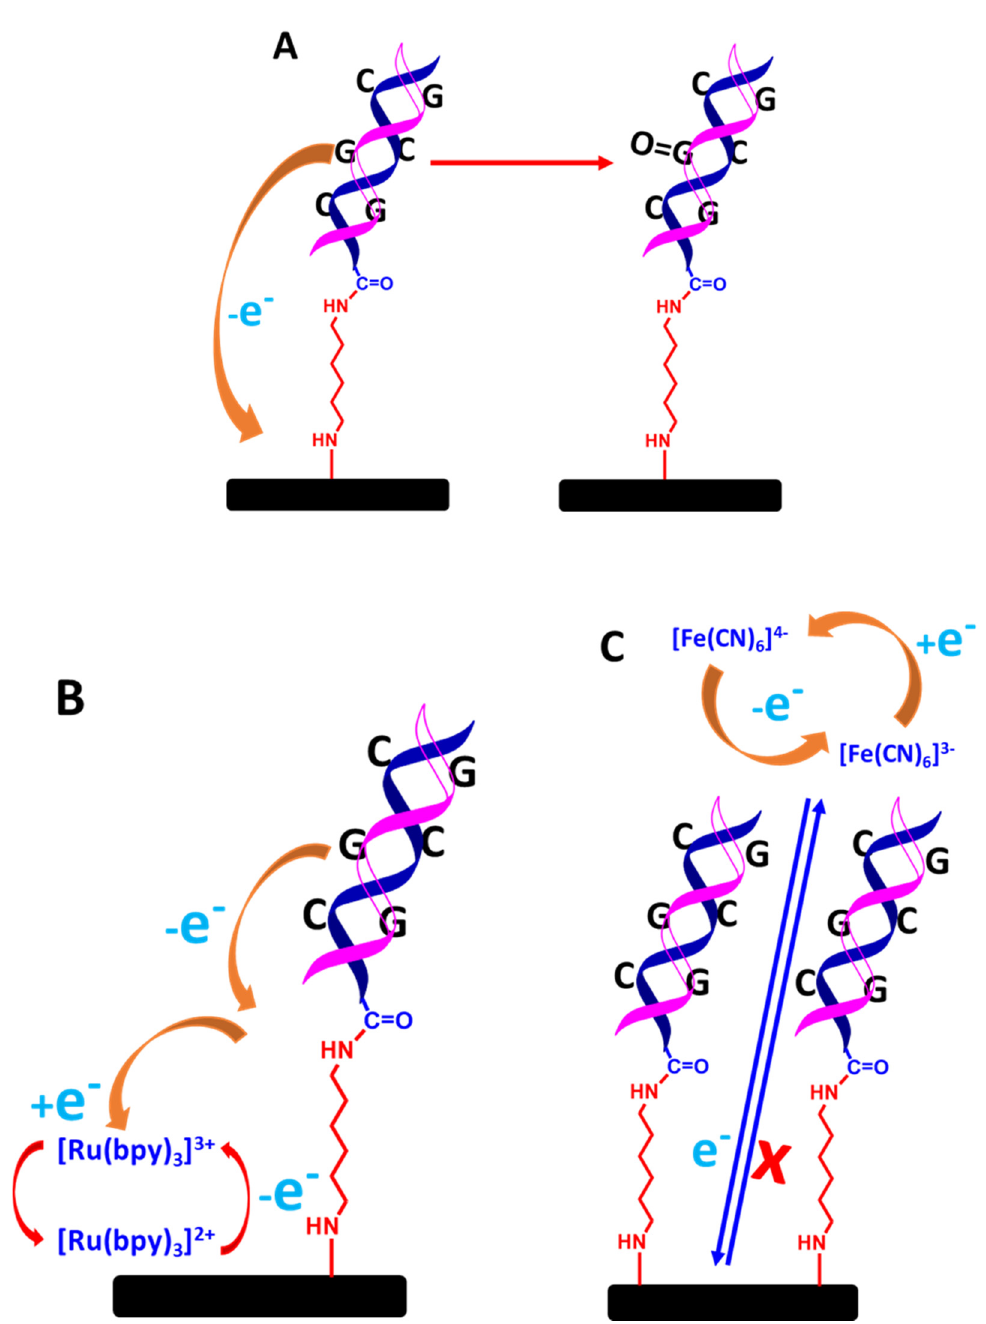
Figure 13. Schematic representation of detecting dsDNA based on label-free electrochemical biosen- sors; ( A ) guanine oxidation only, ( B ) guanine oxidation mediated by ruthenium complex in solution, and ( C ) blocking effect of ferrocyanide and ferricyanide redox couple [Fe(CN 6 )] 3 − /4 − in solution. The relative sizes of carbon electrodes, primary amine linkers, dsDNA chains are not to scale.